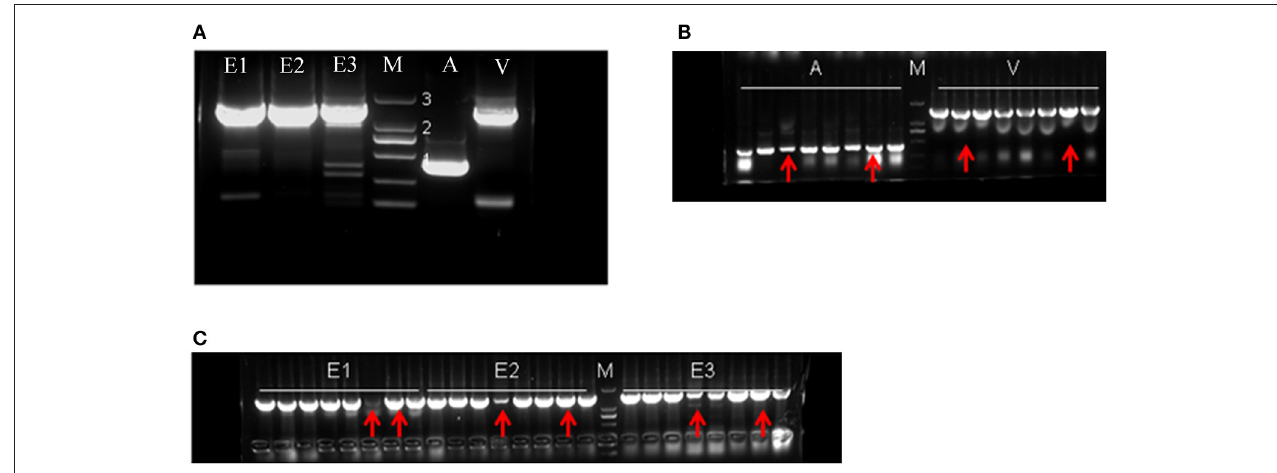
FIGURE 4 | The electropherogram of gene cloning. (A) Result of PCR amplification. (B,C) PCR results for the recombinant vectors; the red arrows indicate the positive clones sent for sequencing. E1: edestin1; E2: edestin2; E3: edestin3; A: 2S albumin; V: 7S vicilin-like protein. Numbers 1, 2, and 3 indicate DNA marker bands, representing 500, 1,000, and 2,000 bp,